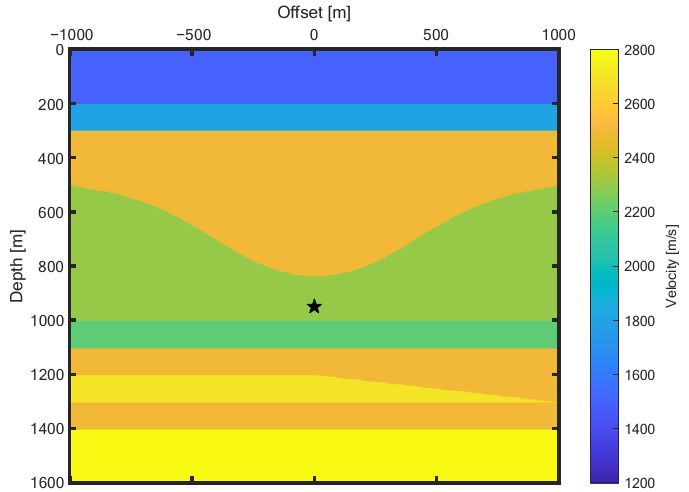
Figure 1. The velocity model. The black star indicates the position of the focal point at (x, z) = (0 m, 950 m).